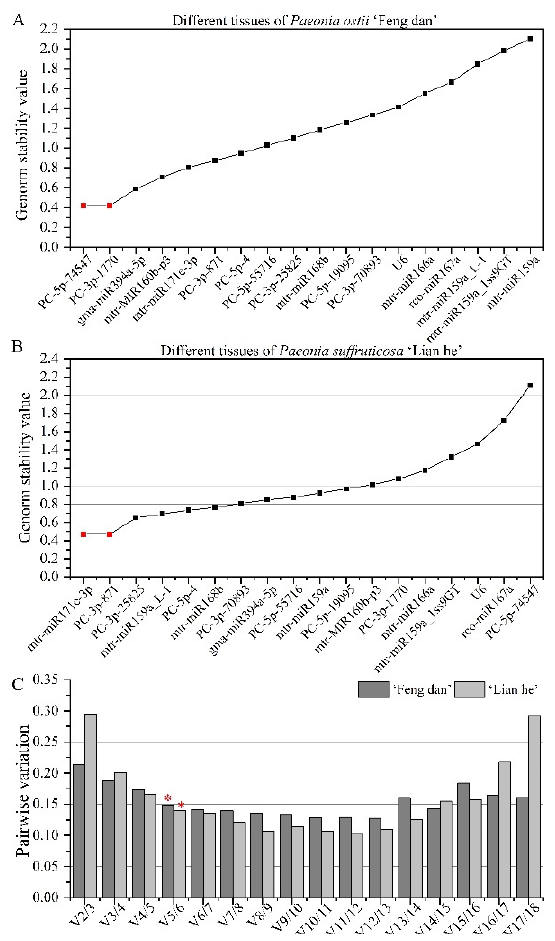
Figure 8. Expression stability analysis and pairwise variation (Vn/Vn+1) analysis of candidate reference miRNAs in different tissues calculated by geNorm. Expression stability results are shown in ( A ) ( Paeonia ostii ‘Feng dan’) and ( B ) ( Paeonia suffruticosa ‘Lian he’) of Figure 8. The most stable miRNA is shown on the left and the least stable miRNA is shown on the right. The red ‘ (cid:4) ’ represents suitable miRNAs. The results of pairwise variation analysis are shown in ( C ). The red ‘*’ represents a suitable quantity.